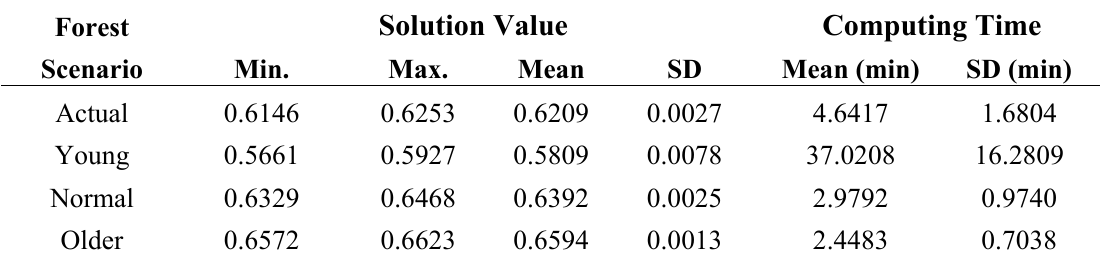
Table 1. Summary of solution quality and computing time of 20 runs for the four forest landscapes with different age class